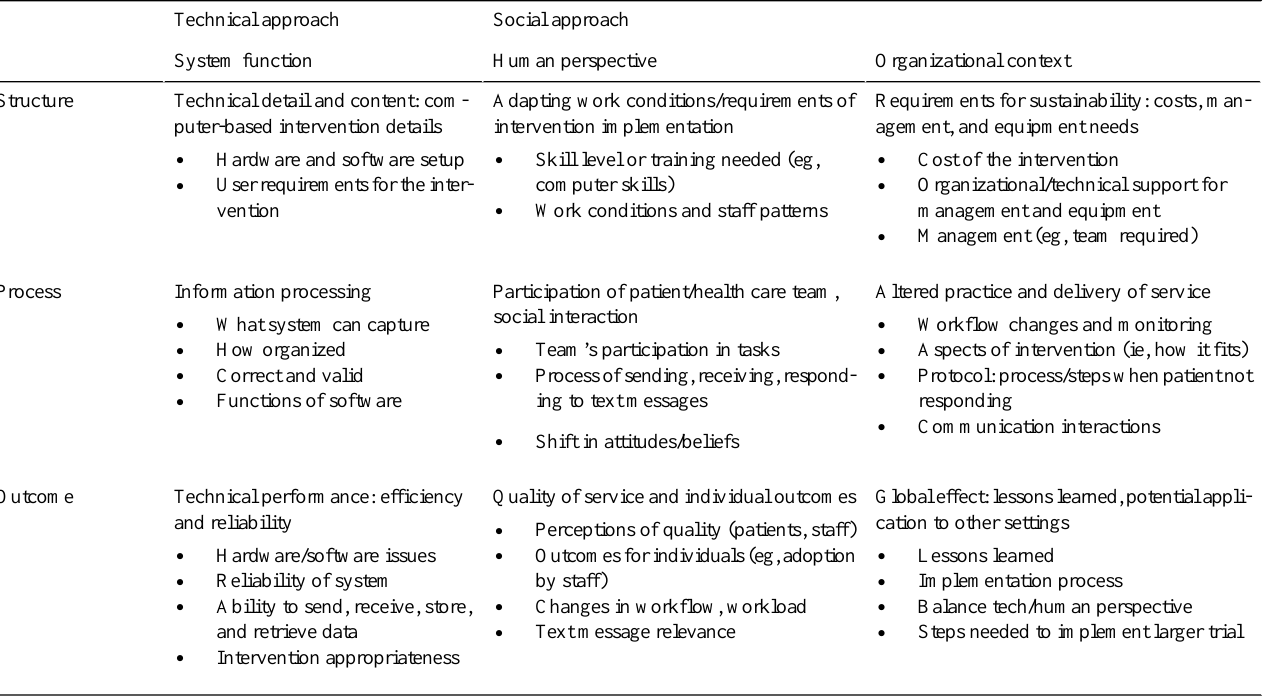
Table 1. Theoretical framework based on the sociotechnical approach a